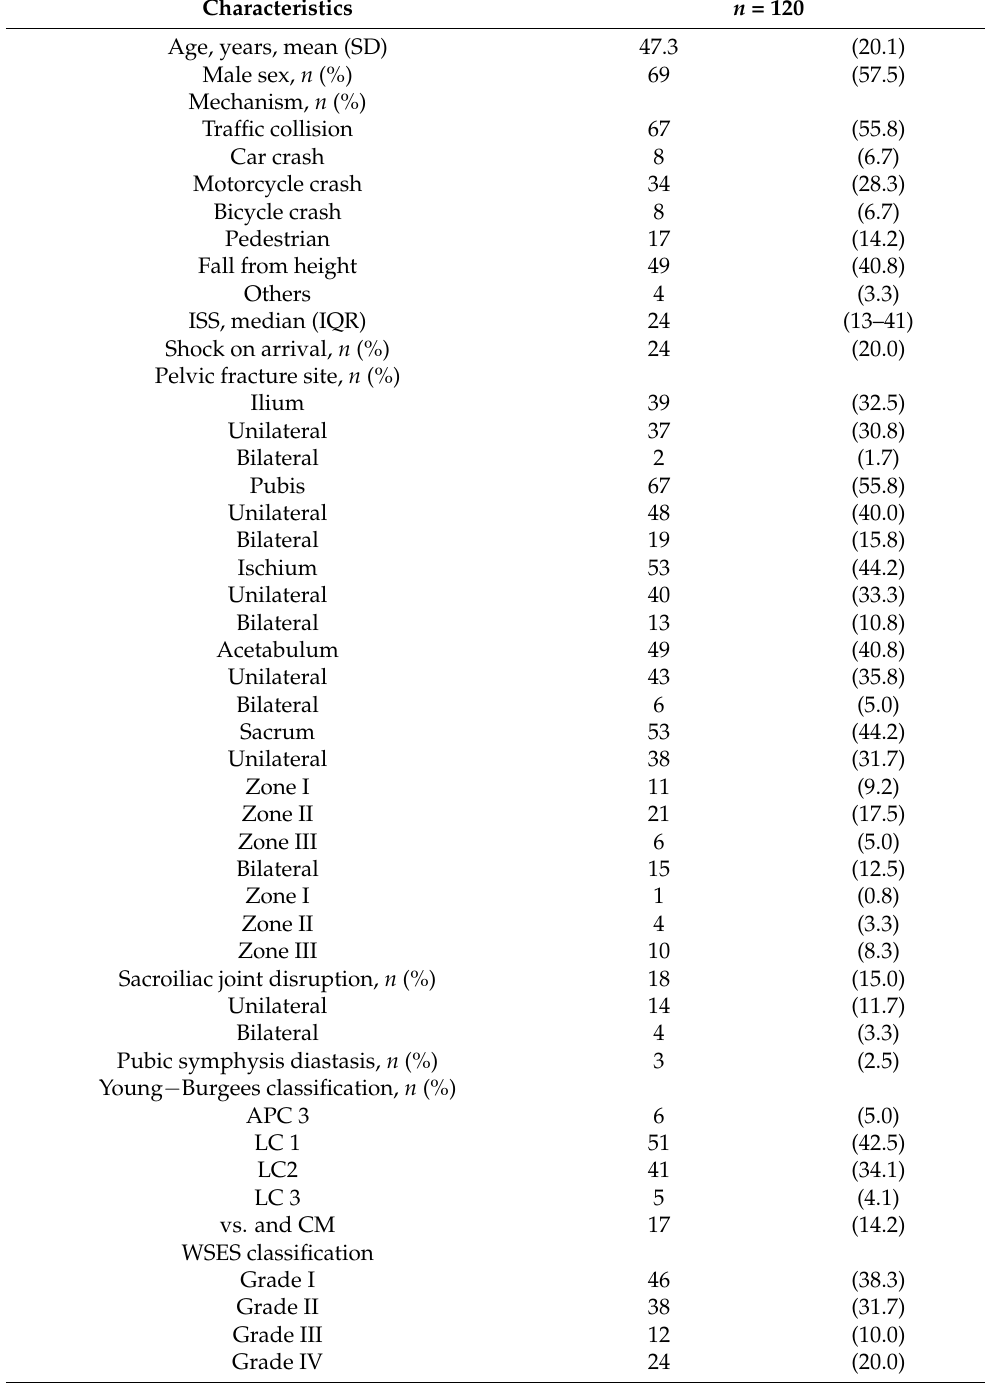
Table 1. Patient characteristics of patients with pelvic